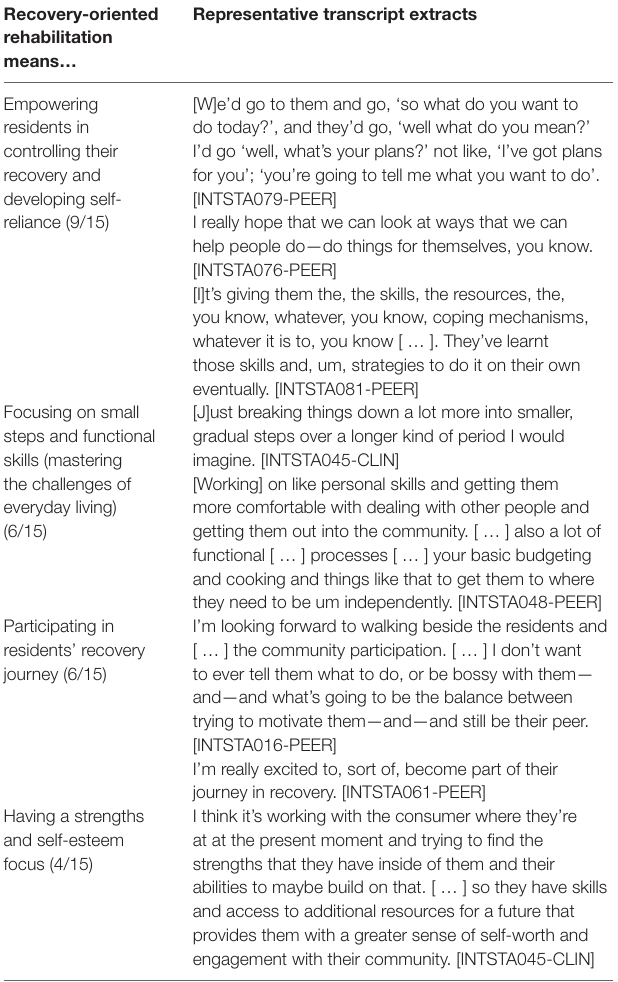
TABLE 4 | Staff concepts of “recovery-oriented